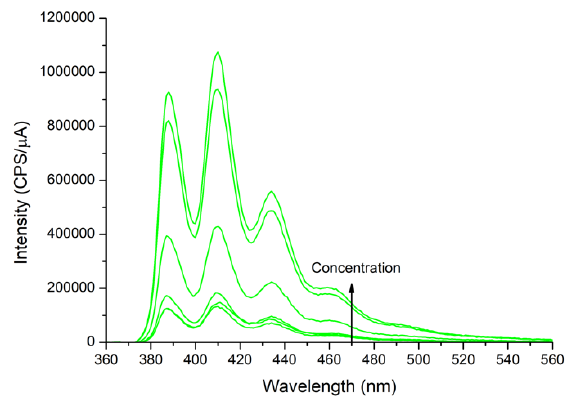
Figure 5. Emission spectra of [Mn II ] compound in ethanol with increasing concentrations (~10 −7 to 10 −6 mol/L). Excitation wavelength: 362 nm.